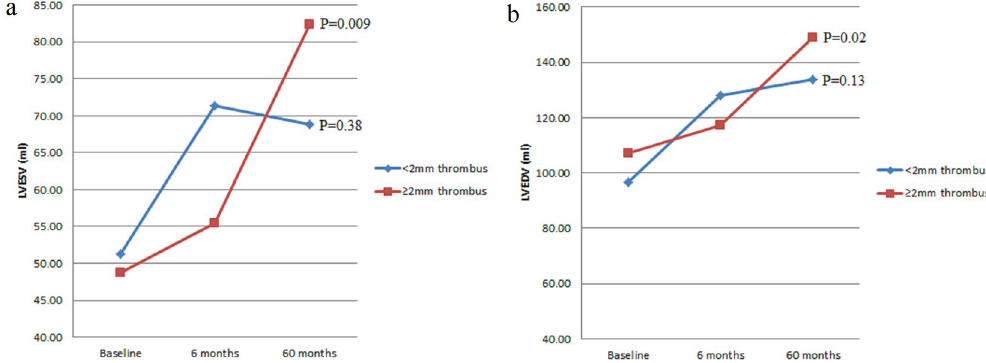
Figure 6. Left ventricular end-systolic (Panel a) and end-diastolic volume (Panel b) evolution from baseline to 60 months follow-up, according to extracted thrombus length. LVESV = left ventricular end-systolic volume; LVEDV = left ventricular end-diastolic volume.